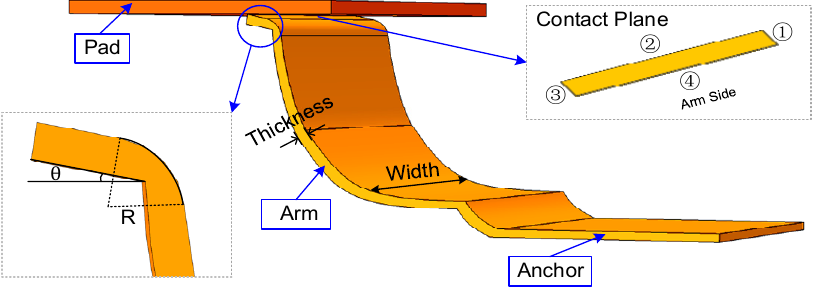
Figure 4. Schematic of the proposed CMI with a sloping contact plane. Table 1. Property of materials.